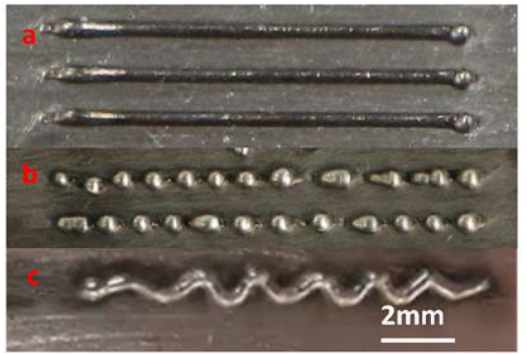
Figure 3. Effect of different parameters on the morphology of specimens in single-track LJWF-DMD AM. ( a ) Successful single track. ( b ) Discontinuity and spheroidization. ( c ) Wire bending and deposition.